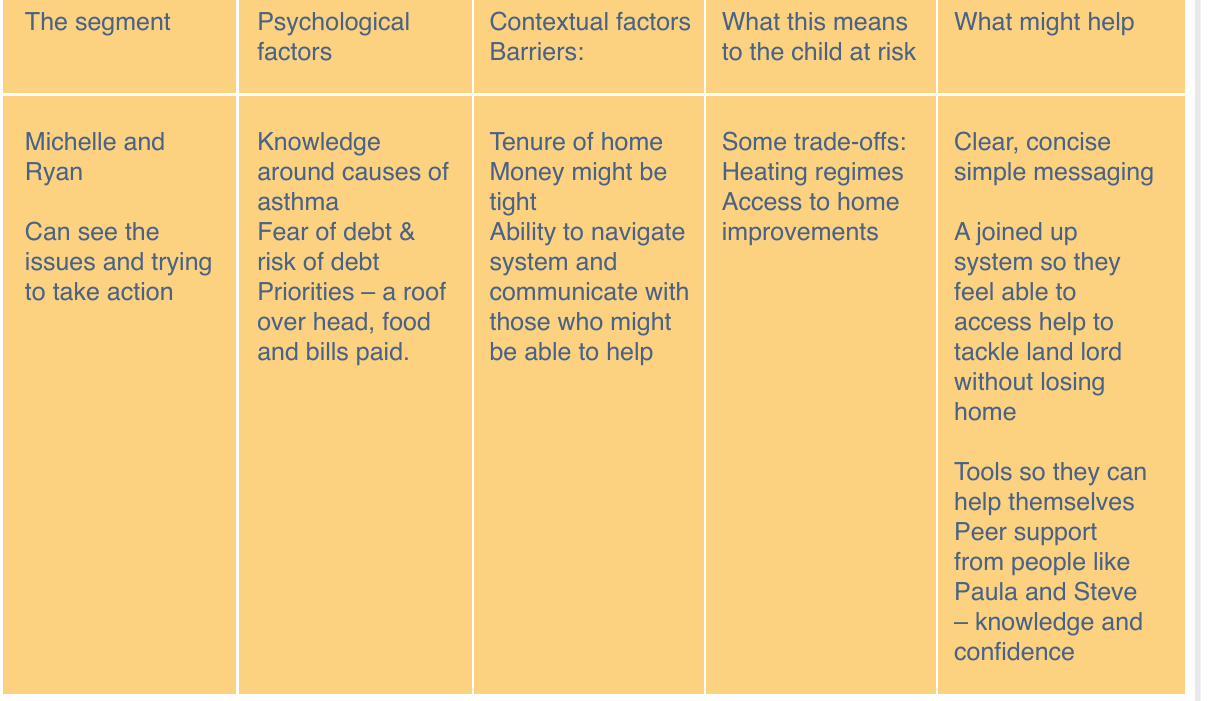
Table 7: The Segmentation Model